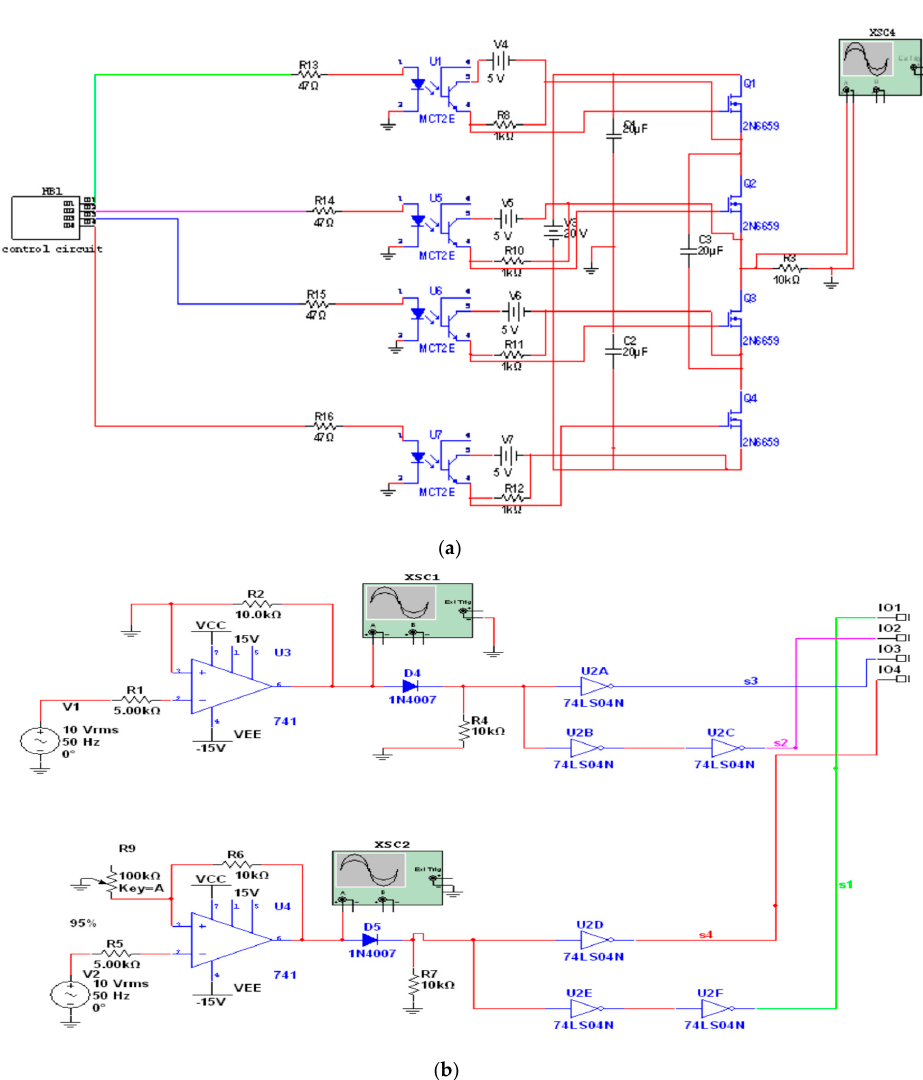
Figure 12. ( a ) Power circuit of 3-Level FC-MLI MULTISIM simulations; ( b ) control circuit of 3-level FC-MLI MULTISIM simulations. FC-MLI MULTISIM